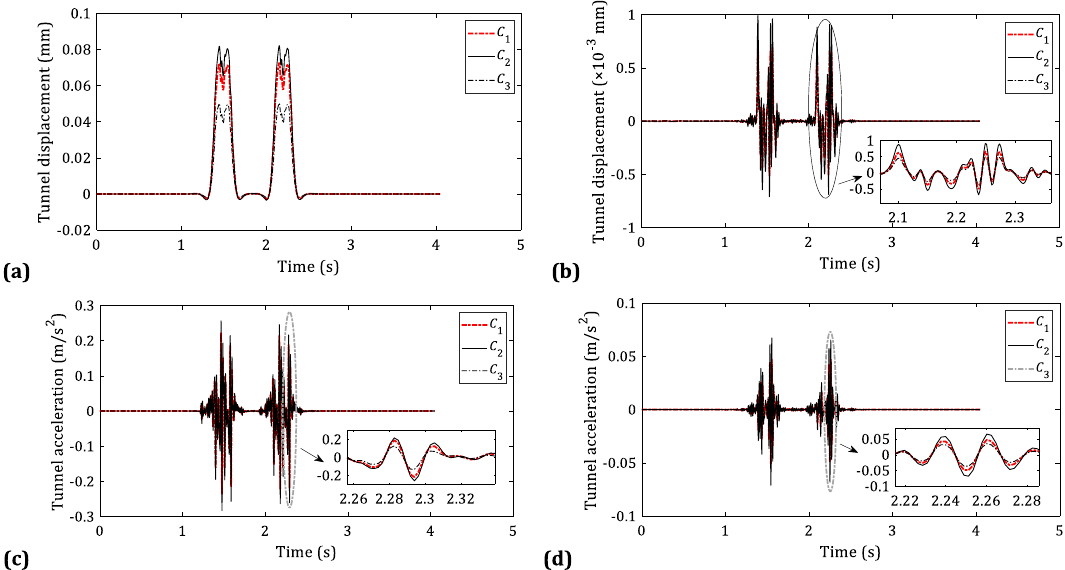
Fig. 14 Comparisons on tunnel segment centroid vibration at the bottom of the track slab: a vertical displacement; b lateral displacement; c vertical acceleration; d lateral